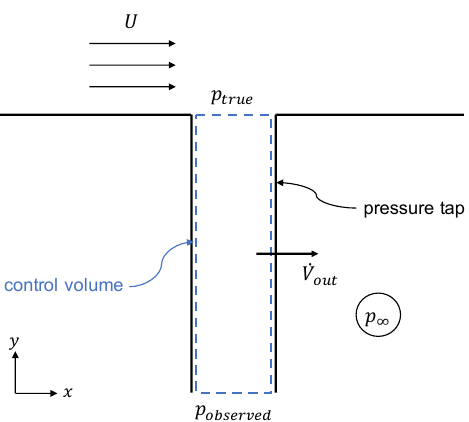
Figure 2. Schematic drawing of the flow over a pressure hole with occurring leakage in the pressure